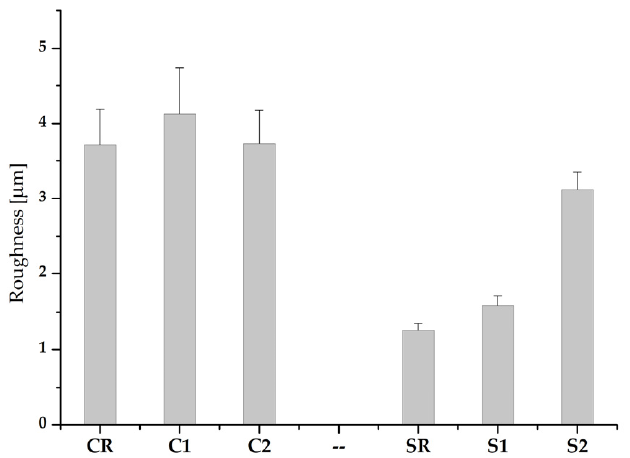
Figure 3. Roughness mean values Ra for C and S samples, before and after the application of the coatings.